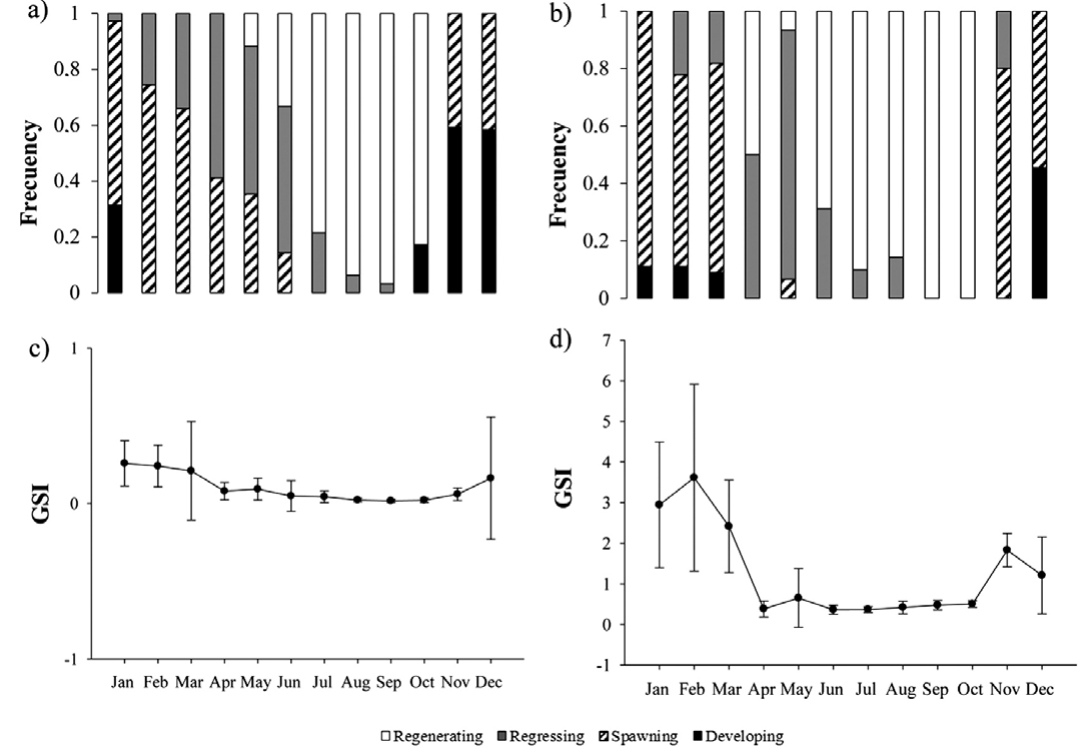
Fig. 6. – Monthly variation of maturity stages and the gonadosomatic index (GSI, mean±SD) for males (a and c) and females (b and